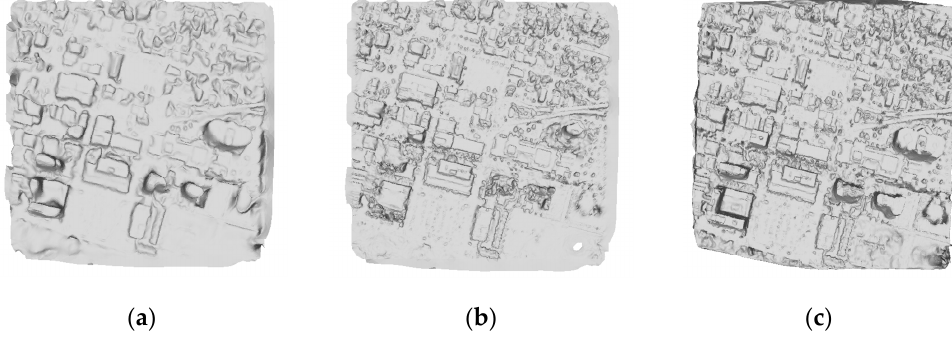
Figure 8. Results with different conditions ( a ) result with higher projection area threshold ( b ) result with low texture complexity threshold ( c ) result with suitable parameters